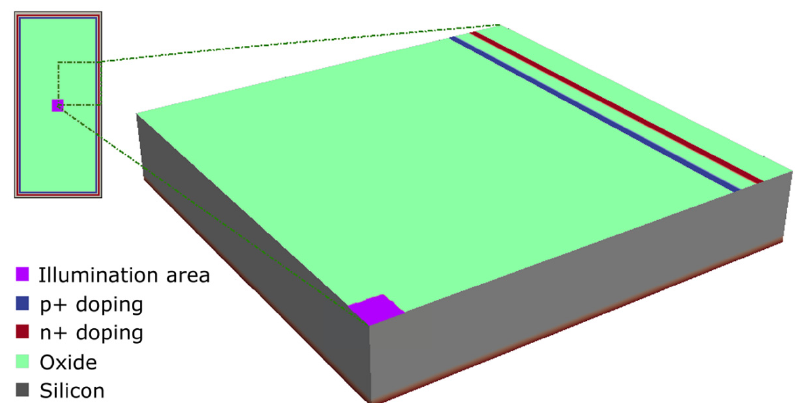
Figure 4. 3D simulation structure of PQED photodiodes.